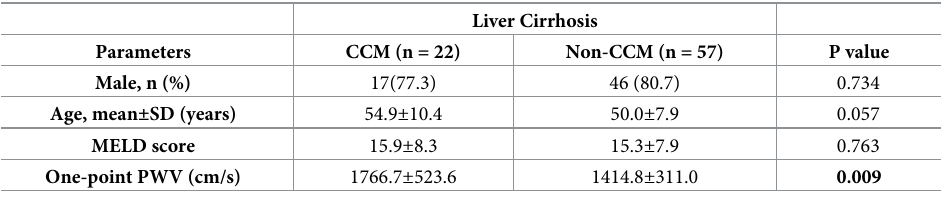
Table 3. Demographic characteristics of CCM and non-CCM cirrhotic